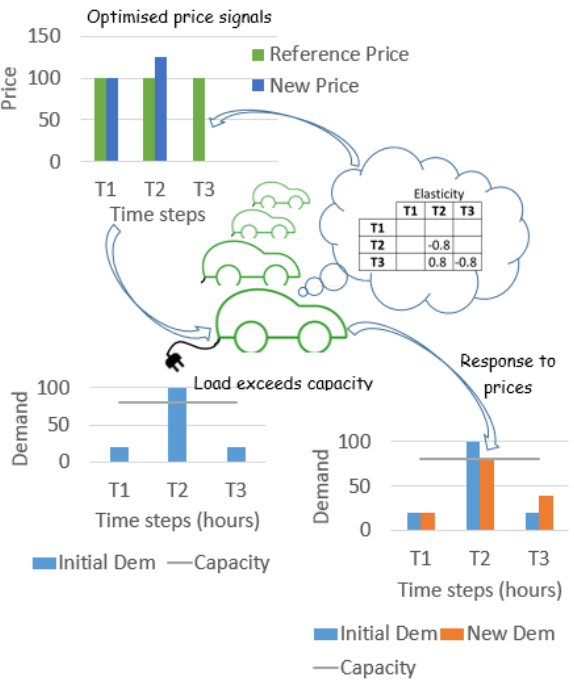
Figure 2. Graphical representation of the basic idea behind pricing models that make use of the elasticity concept to handle electric vehicle charging